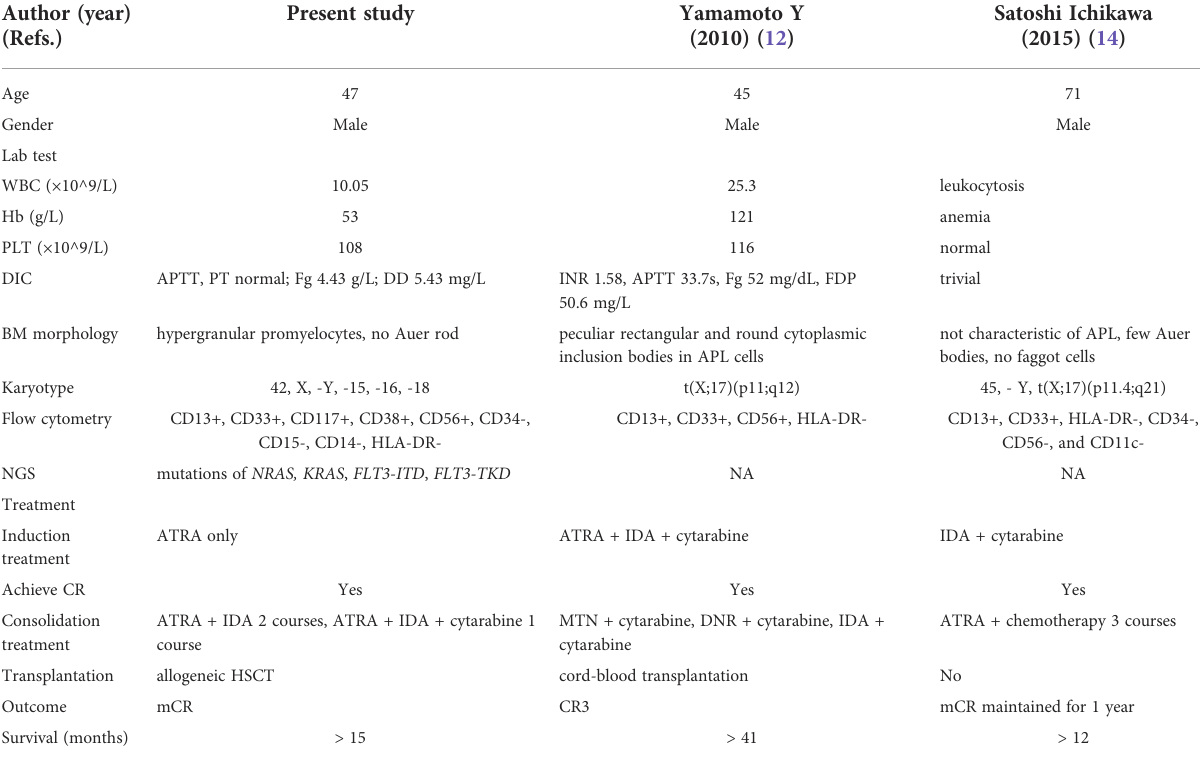
TABLE 1 Comparison of clinical features of the three cases of acute promyelocytic leukemia with BCOR-RARA fusion. Author (year) (Refs.)